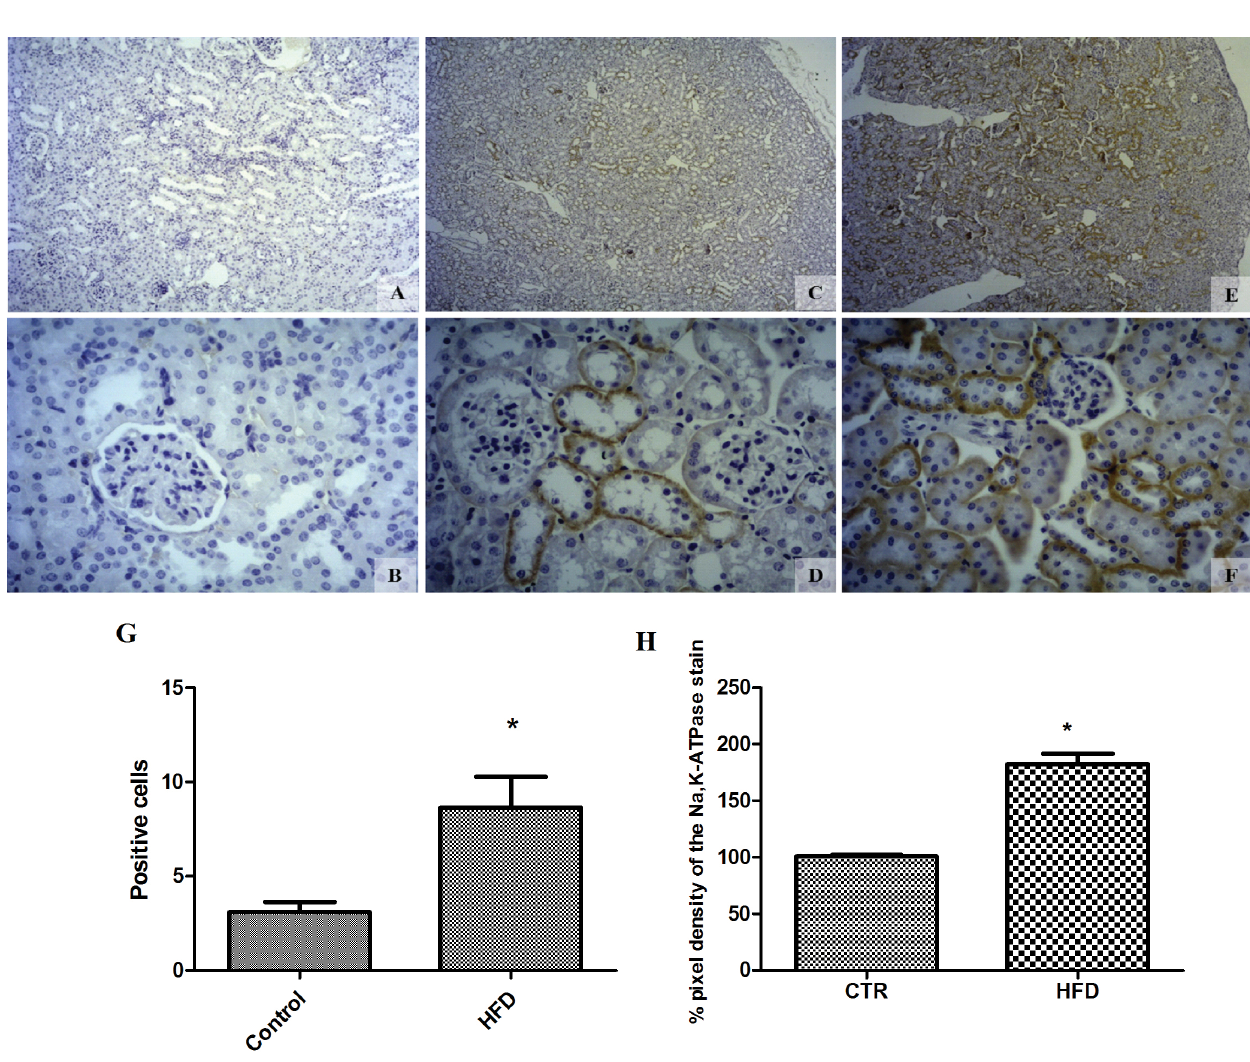
FIGURE 5 - Kidney Na,K-ATPase expression and location in mice treated with high fat diet. Immunohistochemistry of Na, K-ATPase alpha 1 subunit. A) Negative control 5x, B) Negative control 40x, C) Control group 5x, D) Control group 40x, E) HFD Group 5x, F) HFD Group 40x and G) Quantitative determination of labeled cells (total amount in 10 fields per experiment). H) Percentage of pixel density of the Na,K-ATPase